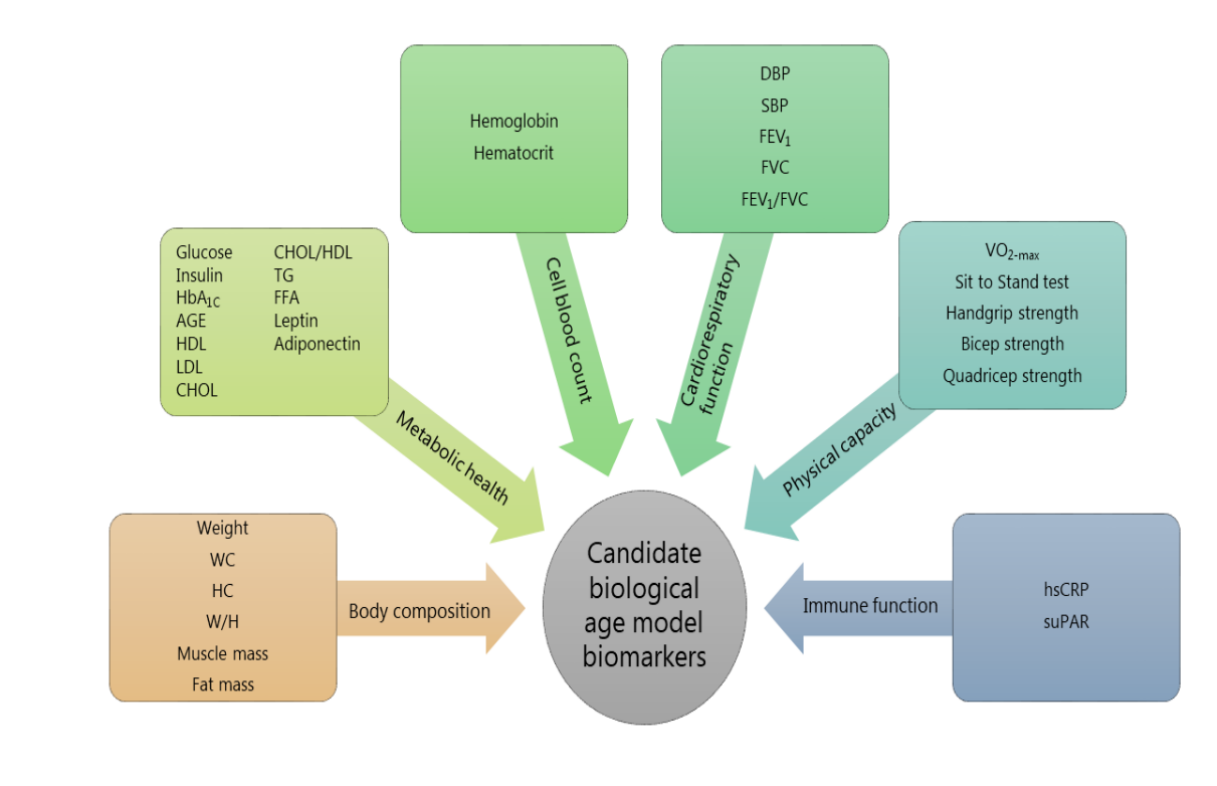
Figure 1. Candidate biomarkers proposed for the BA model. Each square represents 1 of the 6 following domains: (1) Body composition, (2) metabolic health, (3) cell blood count, (4) cardiorespiratory function, (5) physical capacity, and (6) immune function. The candidate biomarkers for the BA model are listed within each domain. AGE: advanced glycation end products; CHOL: Total cholesterol; CHOL/HDL: HDL to CHOL ratio; DBP: Diastolic blood pressure; FEV 1 : Forced expiratory volume within 1 second; FEV 1 /FVC: FEV 1 -FVC ratio; FFA: Free fatty acids; FVC: Forced vital capacity; Hb A1c : Glycated hemoglobin; HC: Hip circumference; HDL: High-density lipoprotein; hsCRP: High-sensitive C-reactive protein; LDL: Low-density lipoprotein; SBP: Systolic blood pressure; TG: Triglycerides; suPAR: soluble urokinase Plasminogen Activator Receptor; VO 2max : Maximal oxygen uptake; WC: Waist circumference; W/H: waist to hip